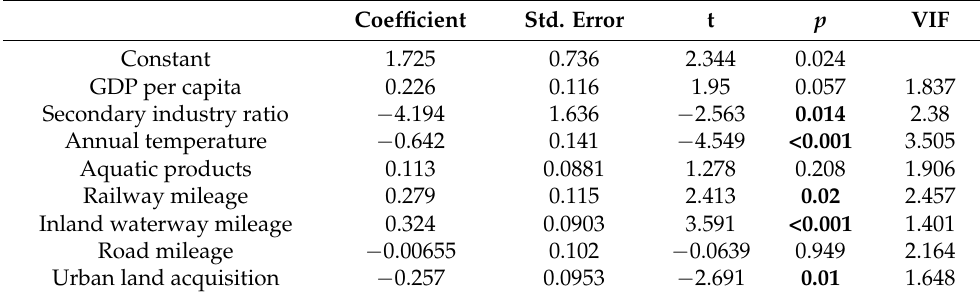
Table 2. Multiple linear regression of wetland area with main climate and socioeconomic factors. Coefficient Std. Error t p